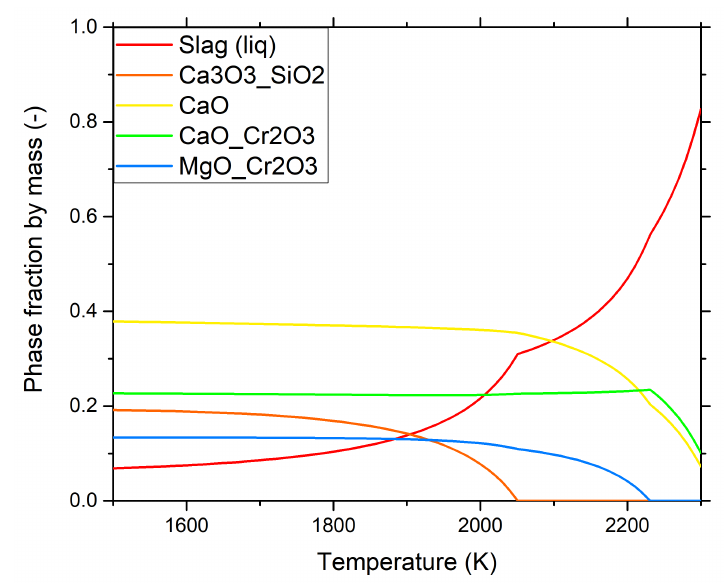
Figure 5. Phases in a typical AOD decarburization slag in the temperature interval 1500–2300 K calculated by using Thermo-Calc